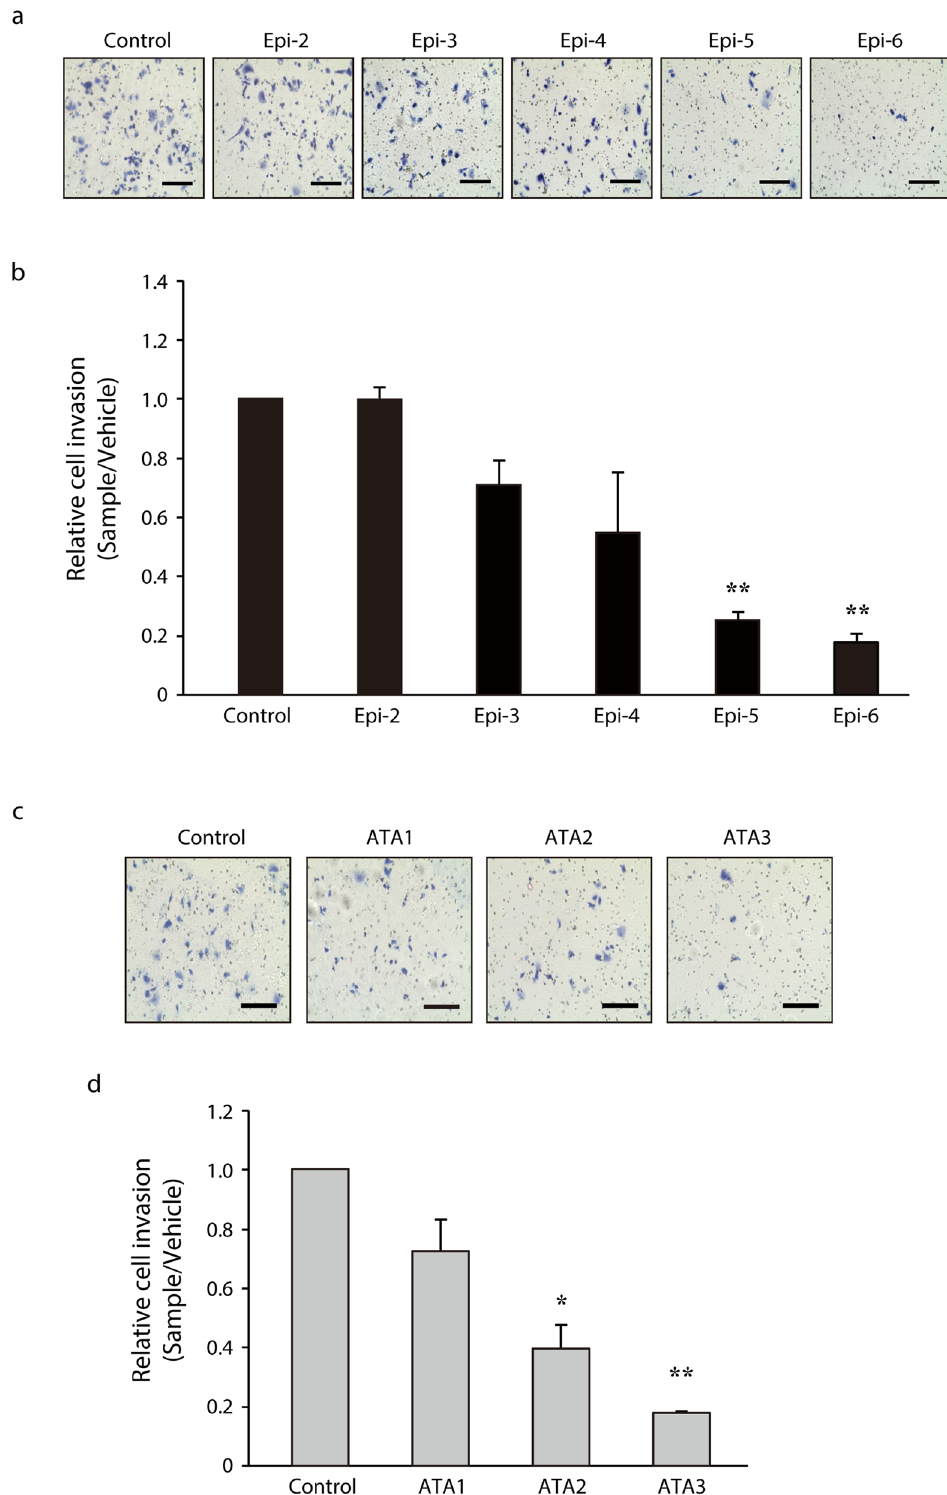
Figure 8. Effects of test compounds on the invasive activity of PC-3 prostate cancer cells. Test compounds (30 μ mol/L) with the degree of oligomerization of epicatechin [pentamer (Epi-5), hexamer (Epi-6), ATA2 and ATA3] decreased invasive activities of PC-3 prostate cancer cells. The experimental procedure for preparation of test compounds was described in Biochemical methods of Supplementary Information. The invasive cells were fixed, stained and counted. Representative images of three independent experiments are shown in ( a ) and ( c ). Scale bar, 400 μ m. The relative activities of cell invasion are shown in ( b ) and ( d ). The data are the means ± S.D. of three independent experiments. One-way ANOVA followed by Tukey’s multiple comparison test was used to compare means. * P < 0.05 or ** P <